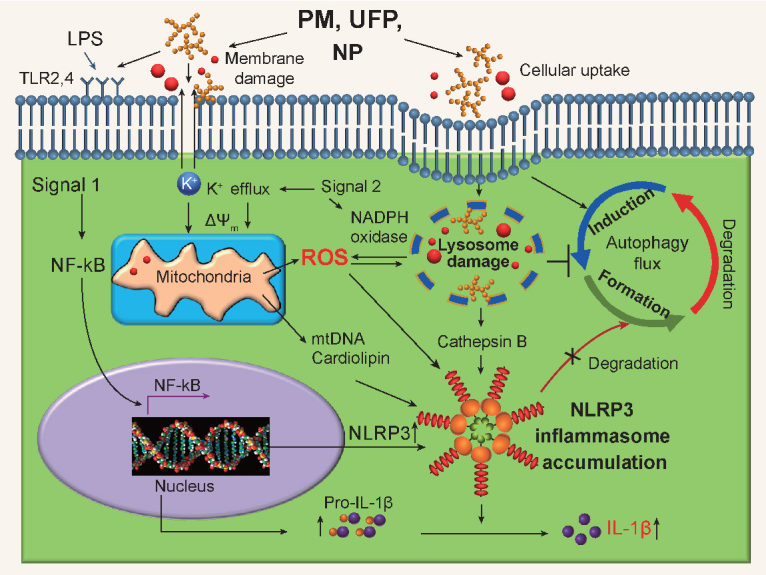
Potential mechanisms of PM-, UFP- and NP-induced NLRP3 inflammasome activation and IL-1β production. Activation of NLRP3 inflammasome complex can be induced by various stimuli including PM and NP particles, and the pro-IL-1β is processed by the inflammasomes to produce mature IL-1β, while IL-1β plays a major role in inducing the pro-inflammatory and pro-fibrogenic effects in the lung. NLRP3 inflammasome activation requires two signals in vitro. For signal 1, pathogen-associated molecular patterns (PAMPs) such as LPS is recognized by Toll-like receptor 4 (TLR4) residing on the cell membrane, which further leads to NF-κB activation and the production of pro-IL-1β and NLRP3 proteins. NLRP3 inflammasome activation mechanisms include ROS generation, potassium efflux, lysosomal damage and cathepsin B release. After phagocytosis of PM, UFPs and NPs, NADPH oxidase is activated to generate ROS. The over-production of ROS may cause the destabilization and permeabilization of lysosomes and cathepsin B release, which will initiate the inflammasome activation cascade. Mitochondrion is another important source of ROS in cells. Over-production of mitochondrial ROS could lead to release of mtDNA and cardiolipin that could induce NLRP3 inflammasome activation. In addition, potassium efflux induced by particles could also induce mitochondrial and cellular ROS production leading to NLRP3 inflammasome activation. Levels of activated NLRP3 inflammasomes are tightly regulated by autophagy.